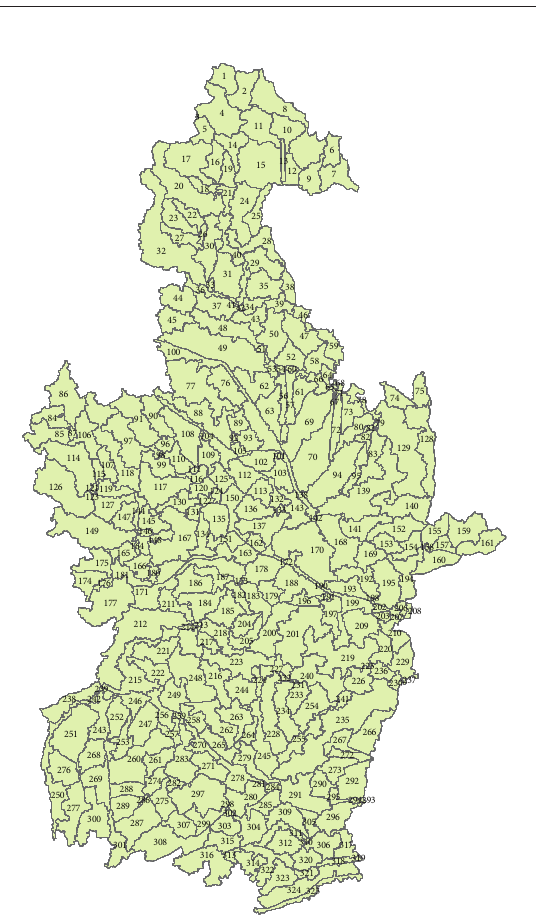
Figure 8: Delineation of watersheds in the Tianjin